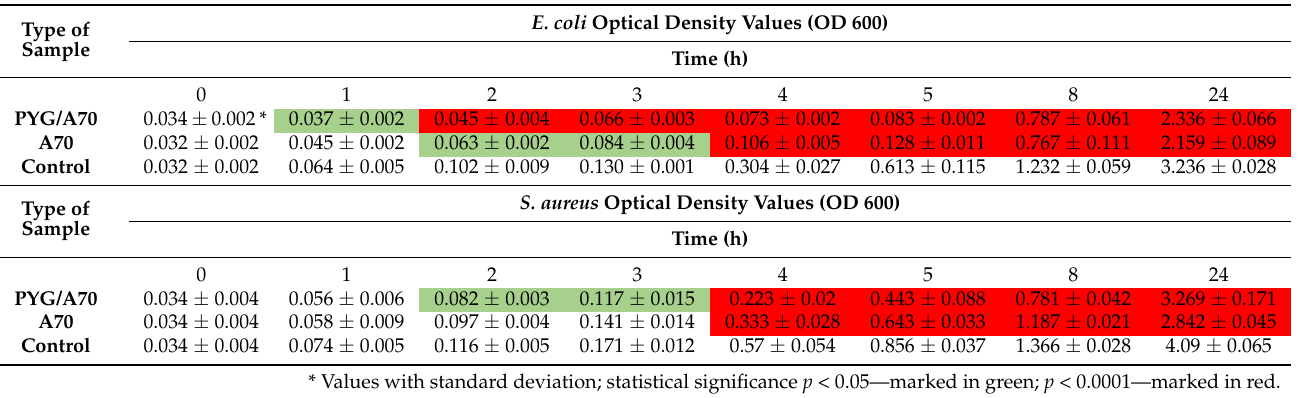
Table 3. Growth dynamics of E. coli and S. aureus in presence of alginate sodium samples with a concentration of alginate 70 mg/mL cross-linked with 1.5 molar barium chloride (A70) and alginate- Pygeum